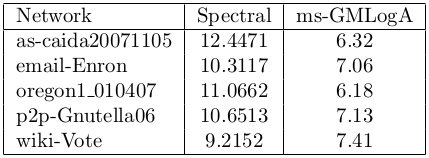
Table from the paper: Multiscale approach for the network compression-friendly ordering
Table text:
Network
Spectral
ms-GMLogA
as-caida20071105
12.4471
6.32
email-Enron
10.3117
7.06
oregon1010407
11.0662
6.18
p2p-Gnutella06
10.6513
7.13
wiki-Vote
9.2152
7.41